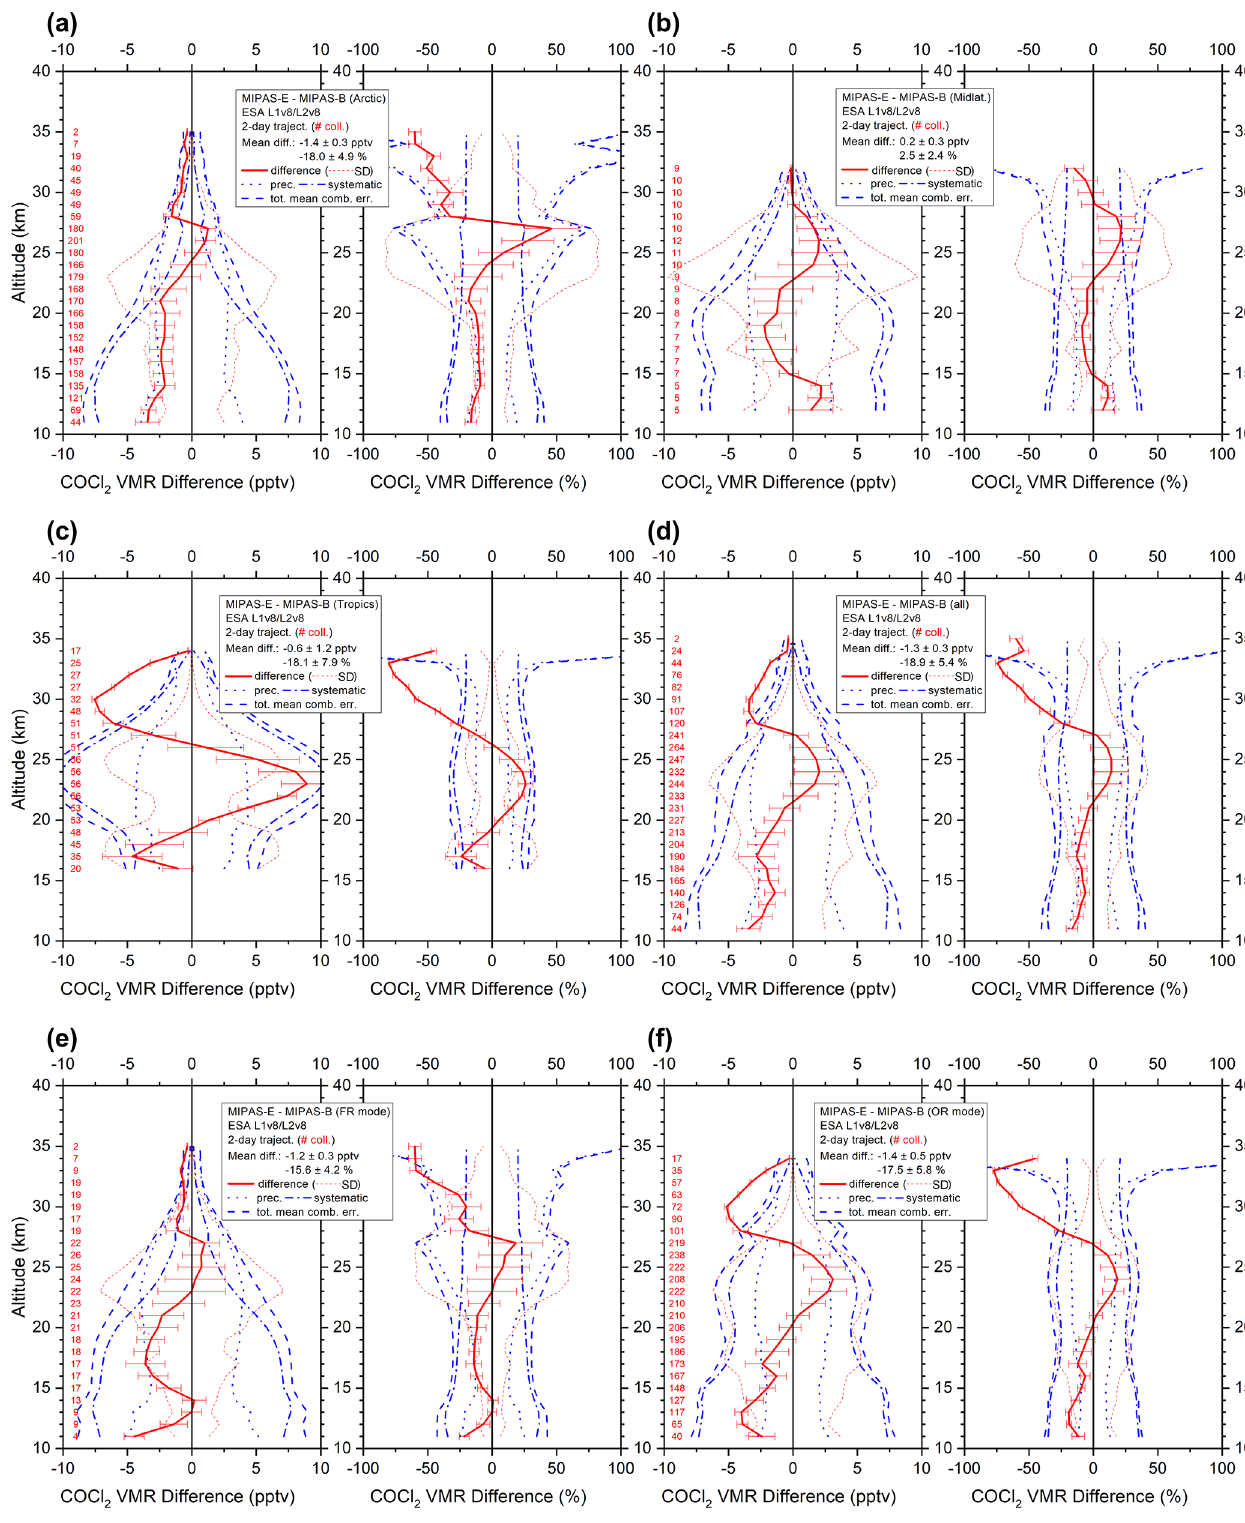
Figure 20. Same as Fig. 3 but for COCl 2